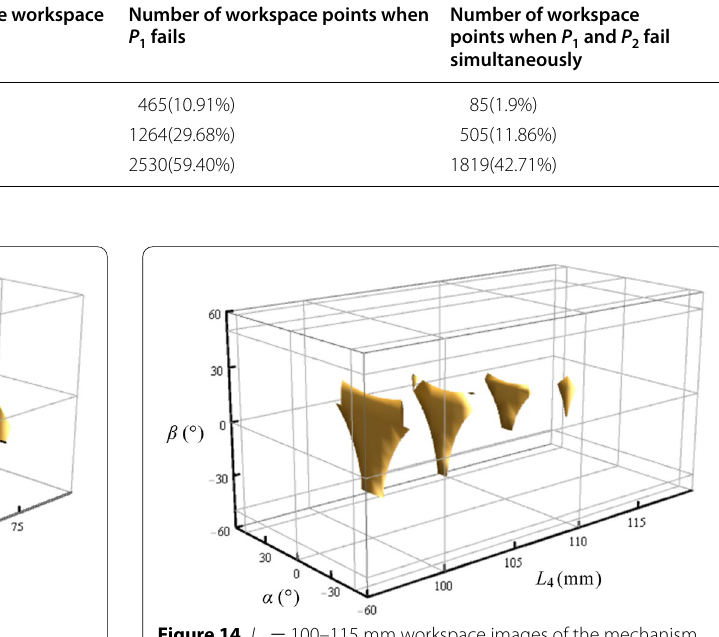
Figure 12 L 4 60–75 mm workspace images of the mechanism =